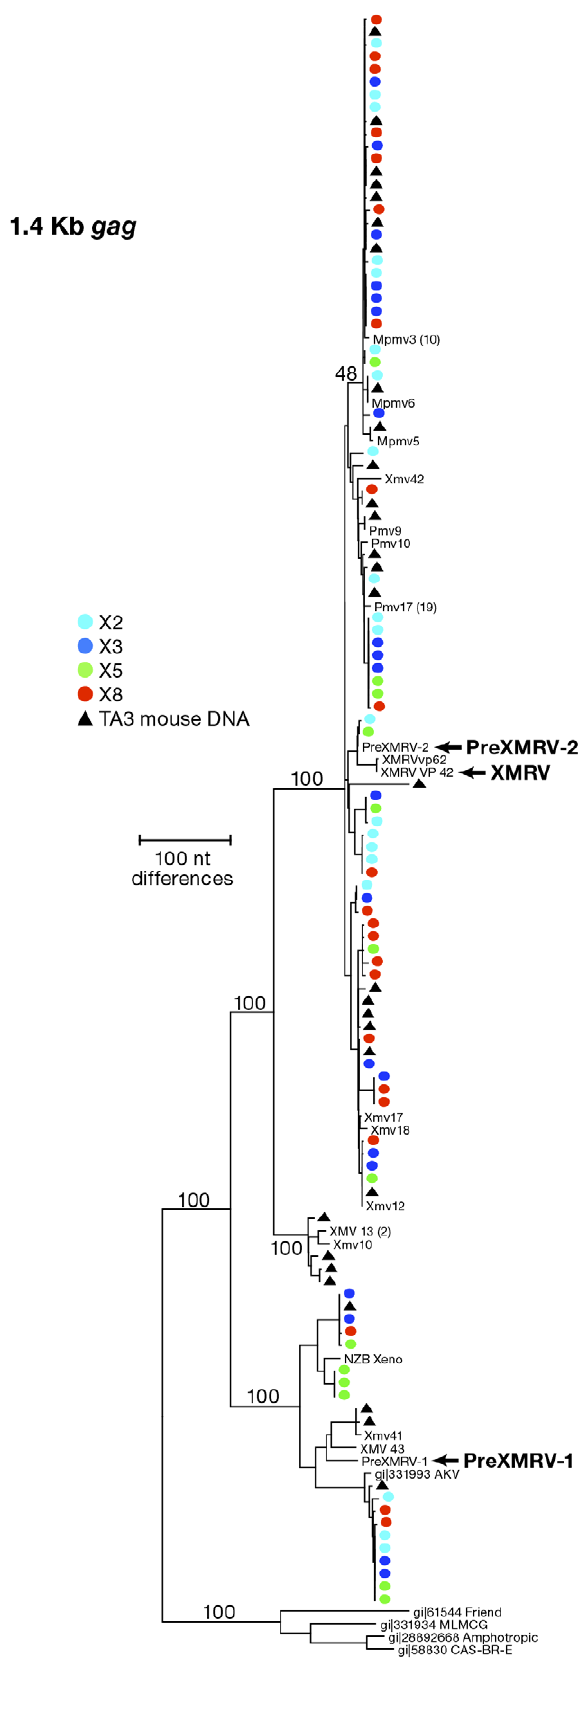
Figure 2. Neighbor-Joining Phylogenetic Tree of sequences obtained by X-SGS from CFS patients’ plasma samples. Phylogenetic structure of gag single-genome sequences obtained from CFS patients X2 (aqua) X3 (blue) X5 (green), and X8 (red), and TA3.Cyc- T1 mouse cells (black triangles). Also includes sequences of endoge- nous MLVs extracted from the C57Bl6 genome sequence [26], as well as XMRV isolates are included for comparison. Where there are multiple identical sequences in the mouse genome, only one is shown, with the number of identical sequences in